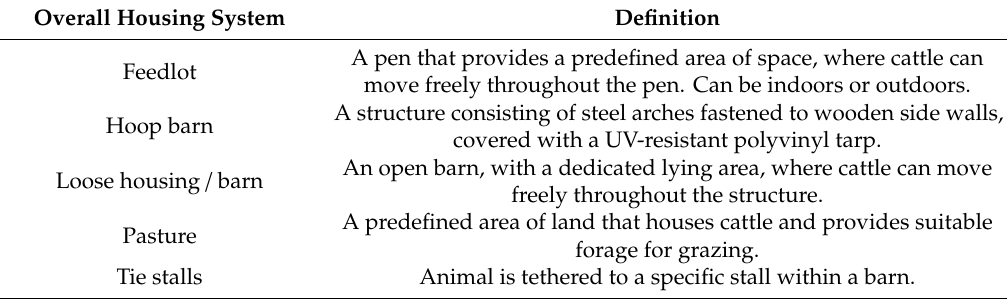
Table 3. Overall housing system definitions used by systematic review authors. These are not equivalent to housing systems’ treatments, which are defined by the original study authors, but are used to describe the housing systems throughout the systematic review.